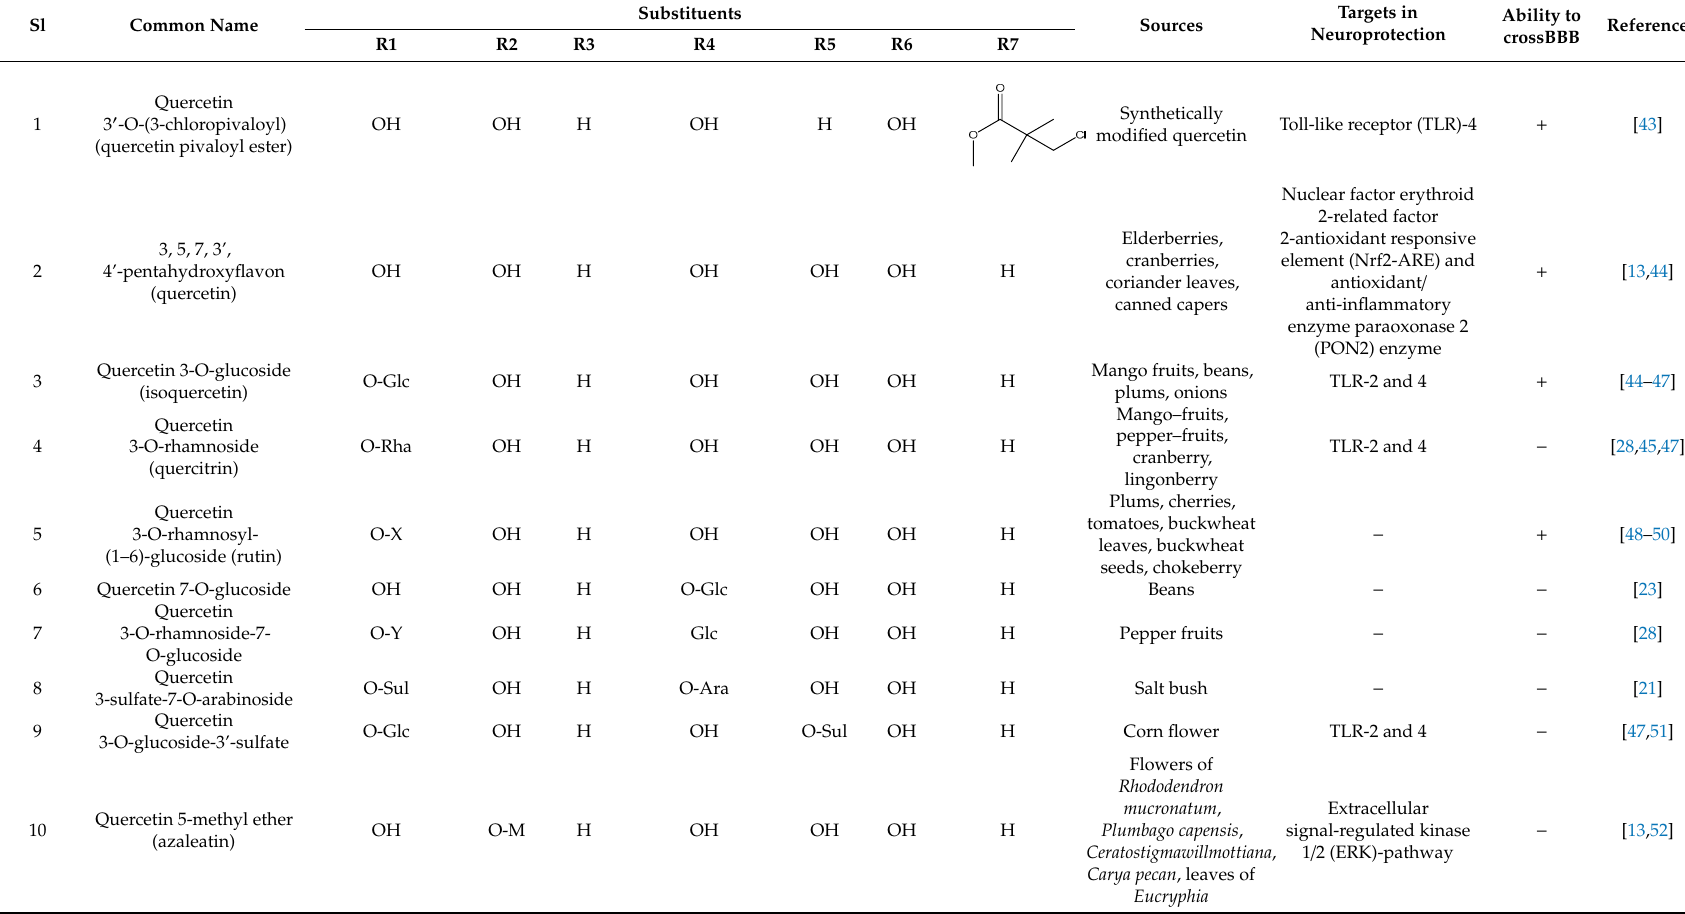
Table 1. Several derivatives of QC with their potential targets for neuroprotective